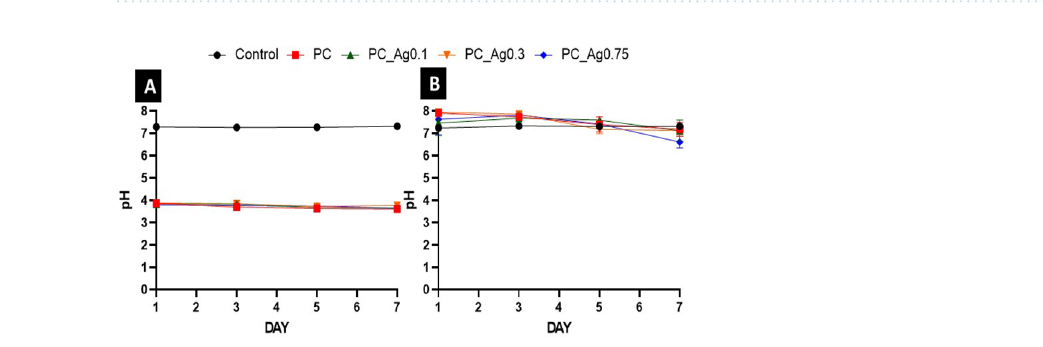
FT‑IR spectroscopy.